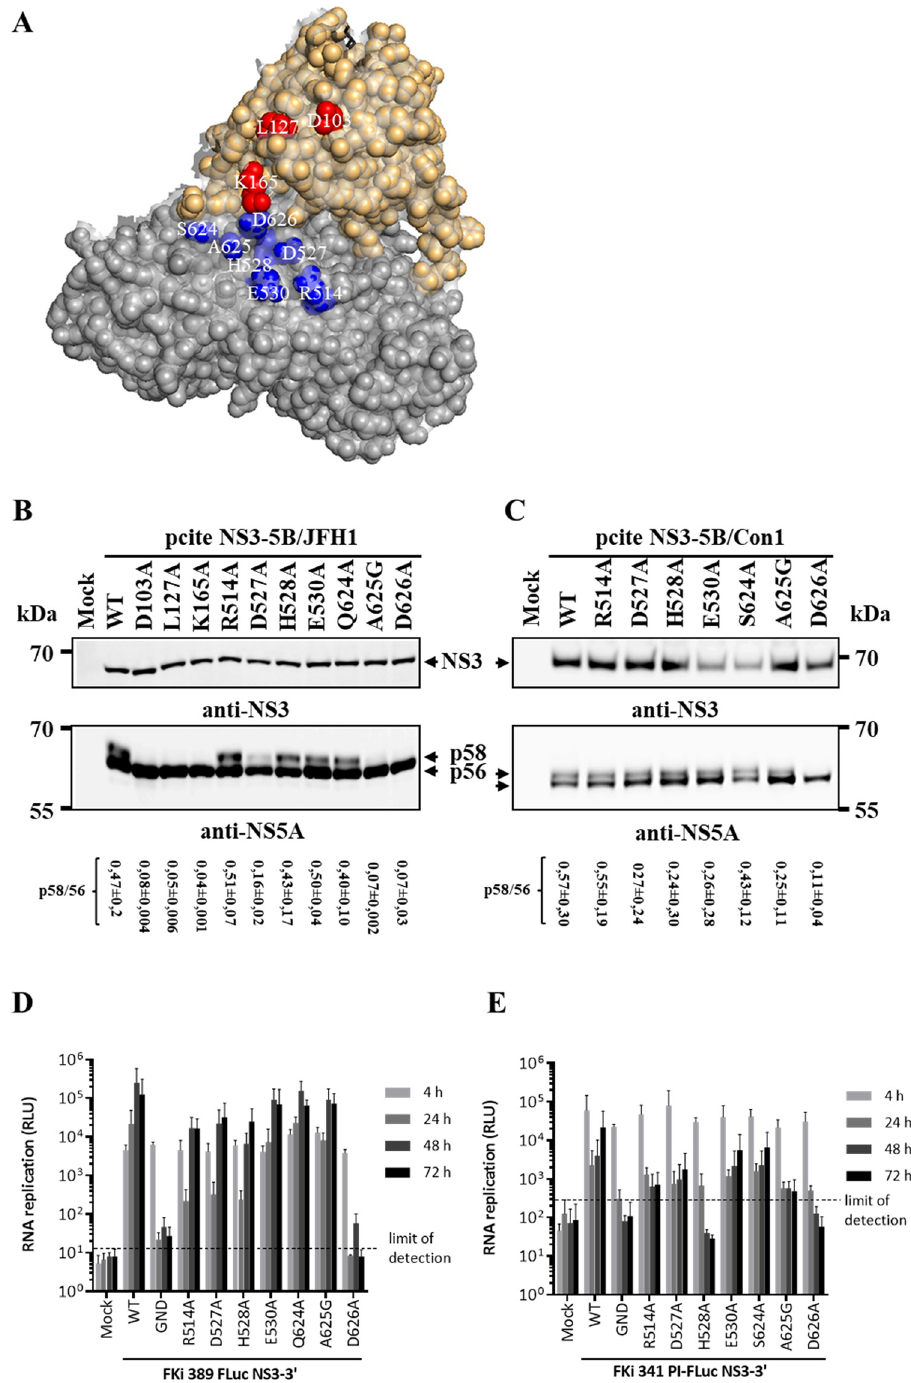
Fig 3. Interrogation of the helicase surface area in close proximity of K165 revealed D626 as important for NS5A hyperphosphorylation and RC assembly. (A) Presentation of the analyzed NS3 helicase surface amino acids. Structural model of NS3 (using coordinates saved in PDB code 1CU1 [57]) showing protease (brown spheres) and helicase (grey spheres) domain surface residues. Red spheres, indicate protease domain residues D103, L127, K165 critical for RC assembly and RNA replication. Blue spheres, indicate surface amino acids of the helicase domain in close proximity to K165 which were analyzed. The illustration was generated in PyMOL (version 1.10). (B and C) MVA-T7 pol -mediated determination of the effect of selected NS3 helicase mutations on HCV polyprotein processing and NS5A hyperphosphorylation. Indicated NS3 helicase mutations were introduced into pcite NS3-5B/JFH1 (B) and